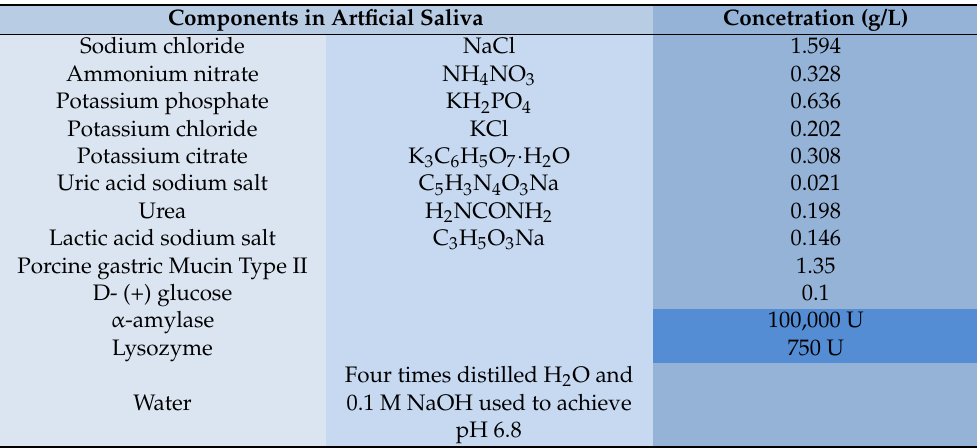
Table 1. Chemical composition of artificial saliva. Reprinted with permission from Refs. [55,56] 2009